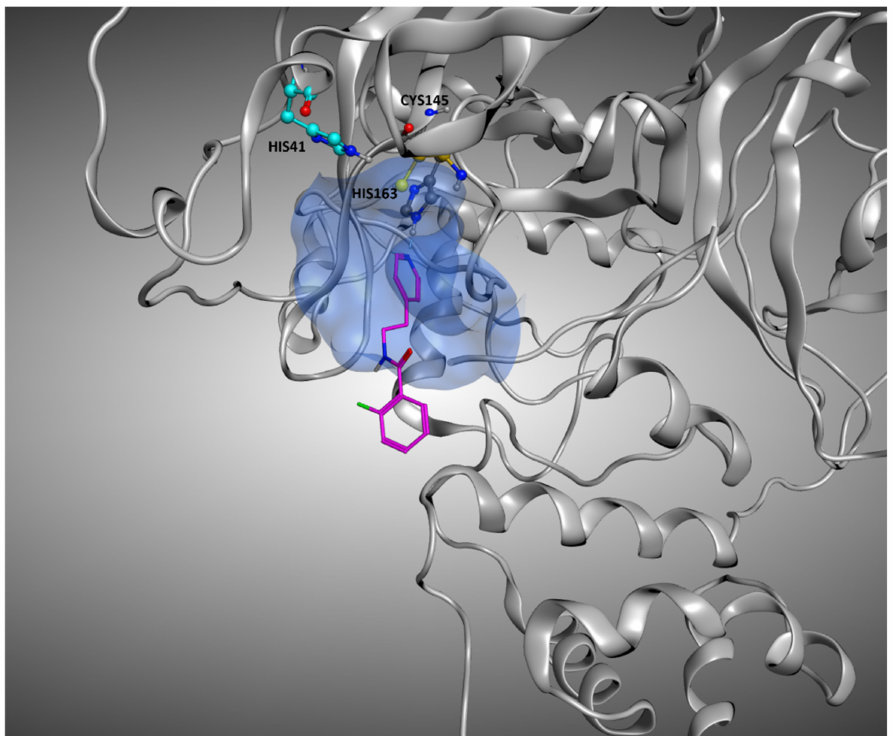
Figure 11. Representation of the crystallographic complex conformation of 5RGK, one of the protein– ligand complexes in which the crystallographic ligand is located inside the orthosteric binding site, but the docking calculation results in high RMSD values. This is mainly due to the high level of solvent exposure that characterizes this ligand, which locates just a small portion of its structure inside the pocket, leaving the rest in an outer zone. The ligand is represented with stick representation (C-atom are colored in magenta), and the catalytic dyad (Cys145 and His41) is highlighted, as well as the His163 and the binding site residue interacting with the ligand. To give a better representation, the surface of the protein in a 5 Å radius from the ligand is represented and colored in